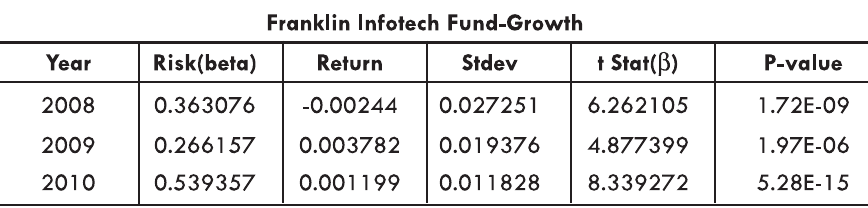
Table 5 : Risk and Returns of Franklin Infotech Fund-Growth Scheme during the Study Period (2008 to